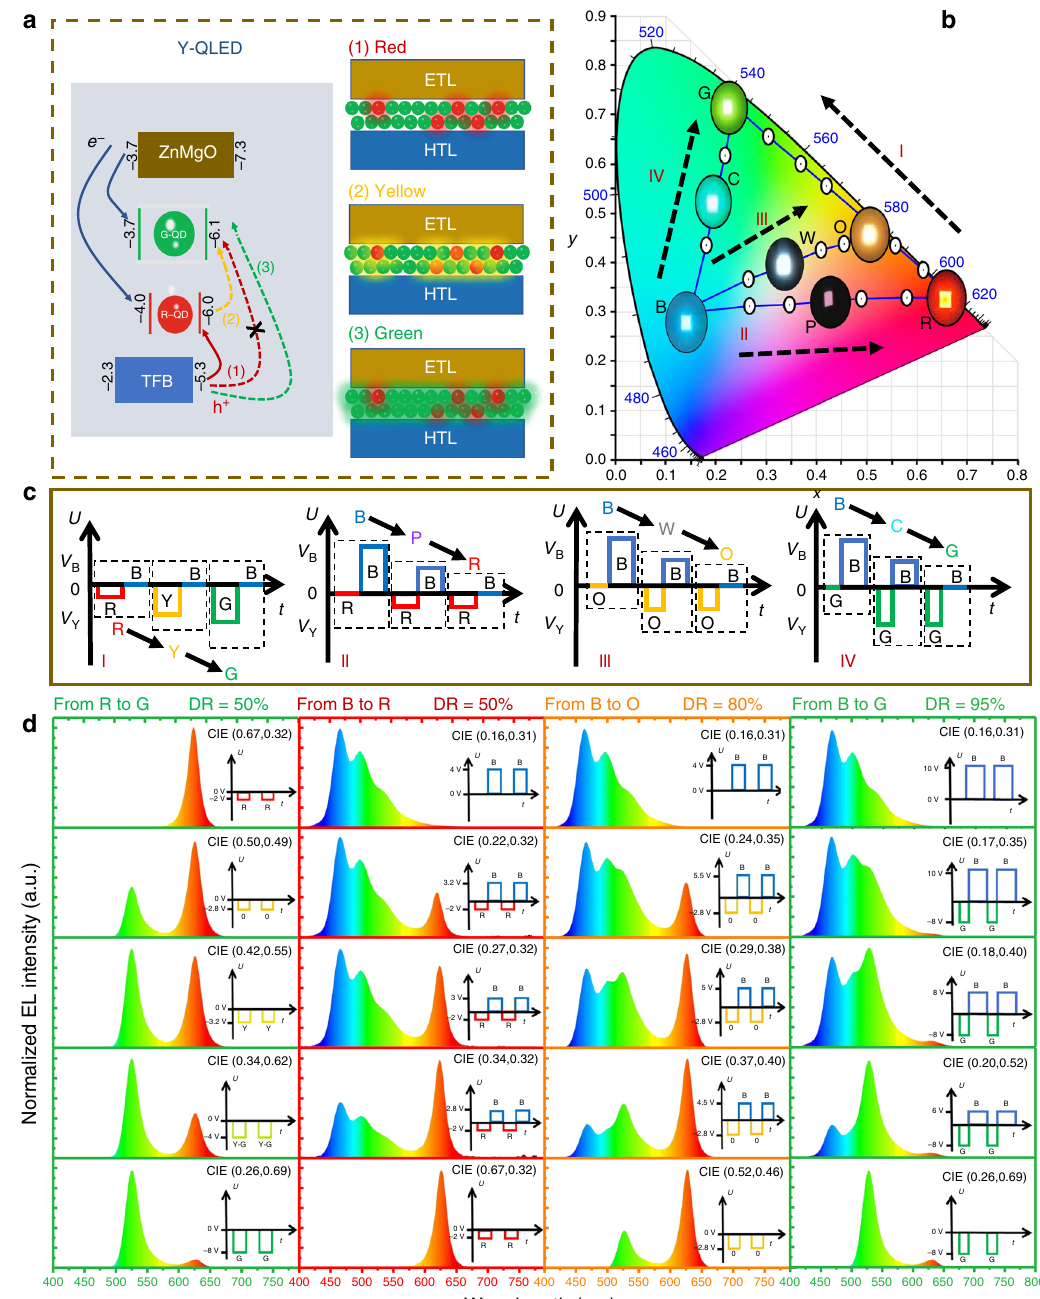
Fig. 2 Mechanism and driving methods of full-color-tunable LED. a Schematic diagram of the charge injection and recombination trajectory of the Y- QLED. The recombination zone is gradually migrated from R-QDs to G-QDs when the driving voltage is increased, and thus the emission color of Y-QLED can be controlled by the voltage. b The CIE chart, CIE coordinates, and photos; c the AC driving signals; and d the emission spectra of a color-tunable device that emits different colors. The color can be continuously tuned from (I) R to G, (II) B to R, (III) B to O, and (IV) B to